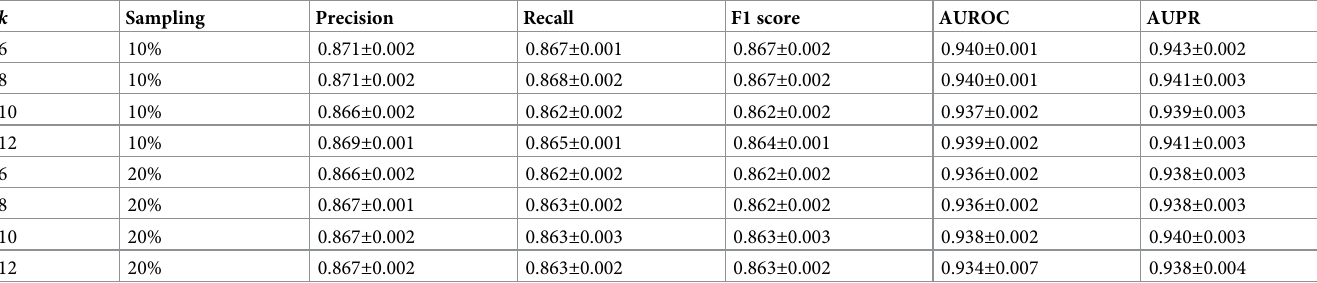
Table 2. Comparing different k -fold cross-validation and the percentage of independent sampling data for testing (evaluating) the GCNMLP.